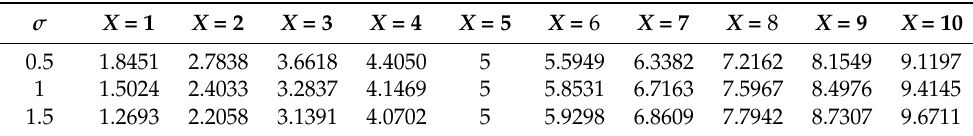
Table 5. Dependence of the value of the function f m ( X ) on σ , the f ( θ ) standard deviation parameter, and the grade X in case 4, when µ = 5, k =